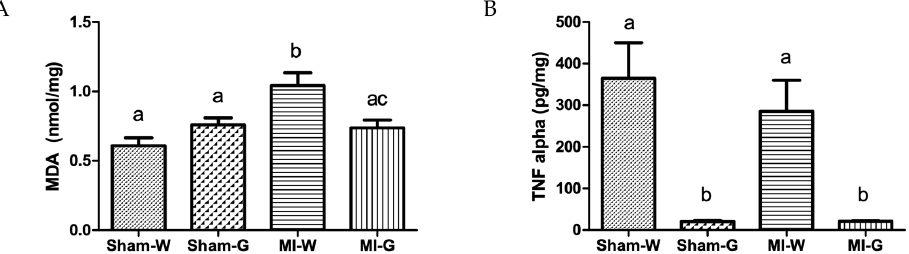
Figure 5. Effect of ginseng berry extract on oxidative stress and inflammation. ( A ) Malondialdehyde (MDA); ( B ) tumor necrosis factor- α (TNF- α ). Values presented are mean ± SEM. Bars with differing letter are significantly different, p < 0.05. Sham-W: Sham MI treated with distilled water ( n = 8); Sham-G: Sham MI treated with GBE 150 mg/kg/body weight/day ( n = 8); MI-W: MI treated with distilled water ( n = 12–14); MI-G: MI treated with GBE 150 mg/kg/body weight/day ( n = 12 – 14).